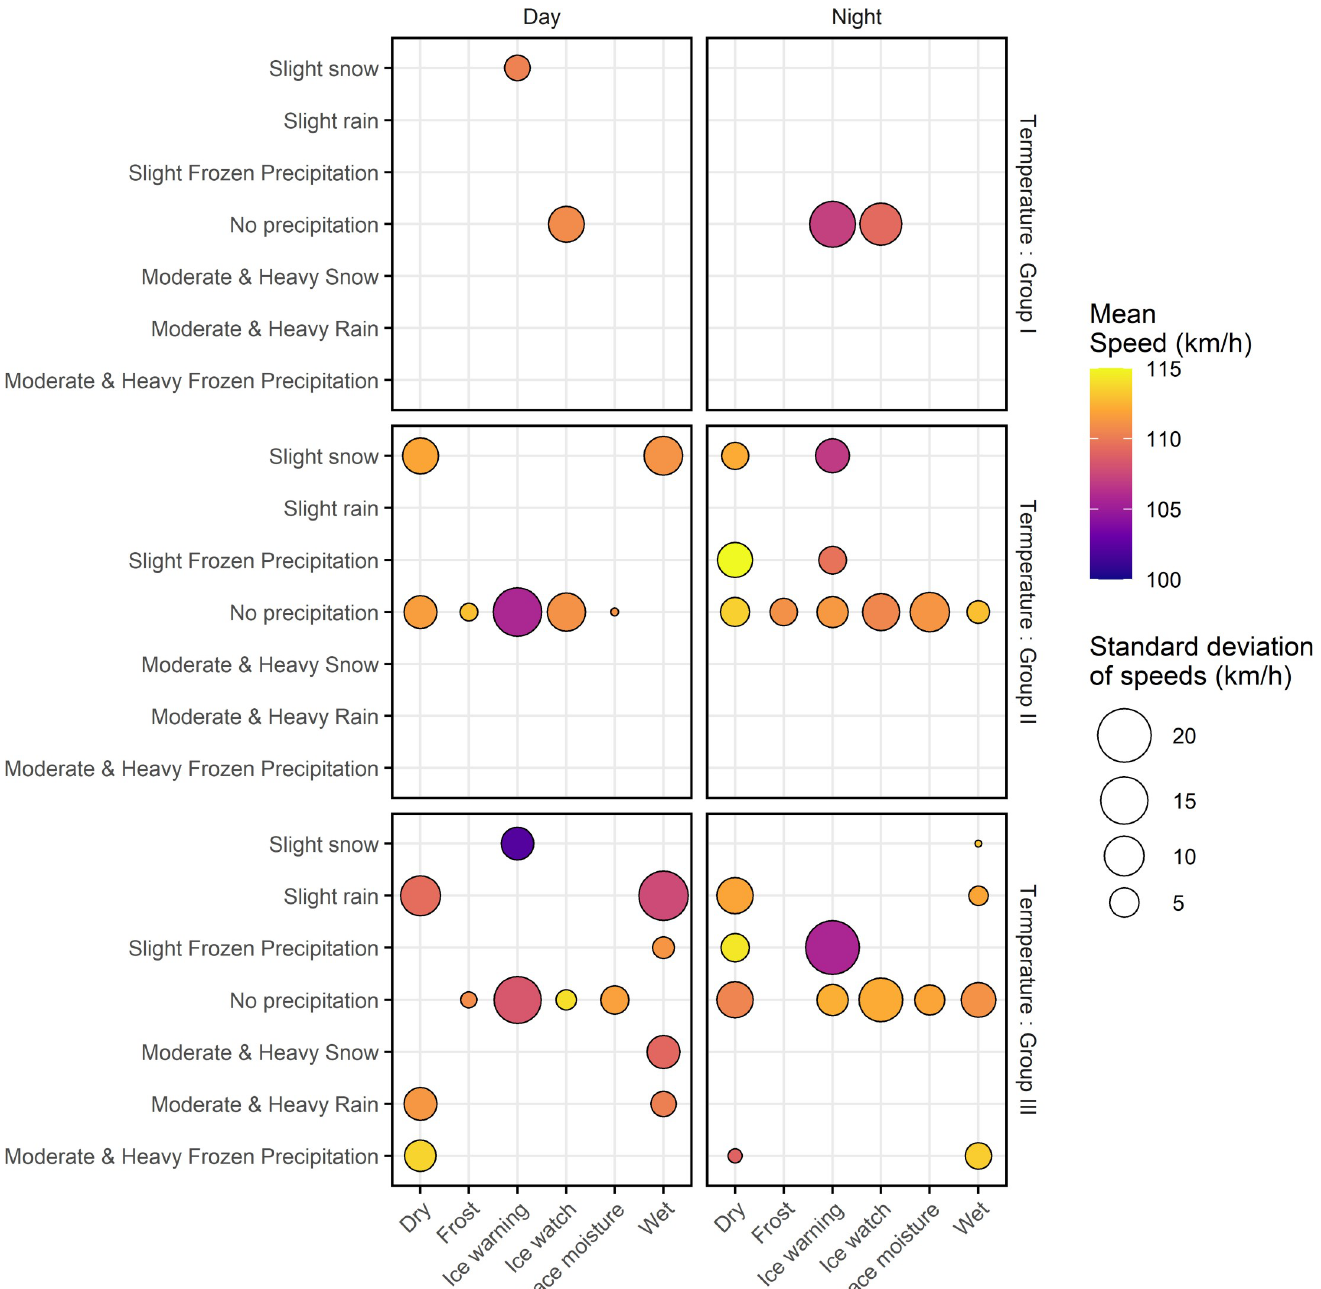
Fig 12. Desired speed distribution characteristics; mean ( μ ) and standard deviation ( σ ) of road-weather combinations under the prevailing traffic conditions.